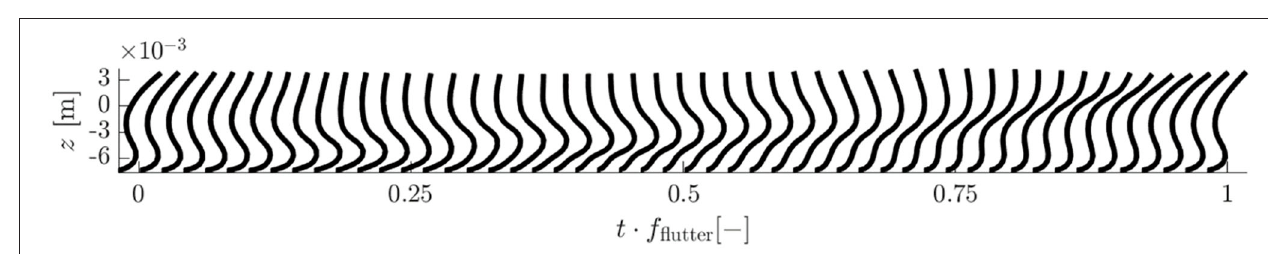
FIGURE 6 | Cross-section of a leaflet through its symmetry plane from base to trailing edge. Its fluttering motion is shown throughout one period of its f flutter = 40Hz oscillation. The transversal deflections of the leaflet are shown to scale.